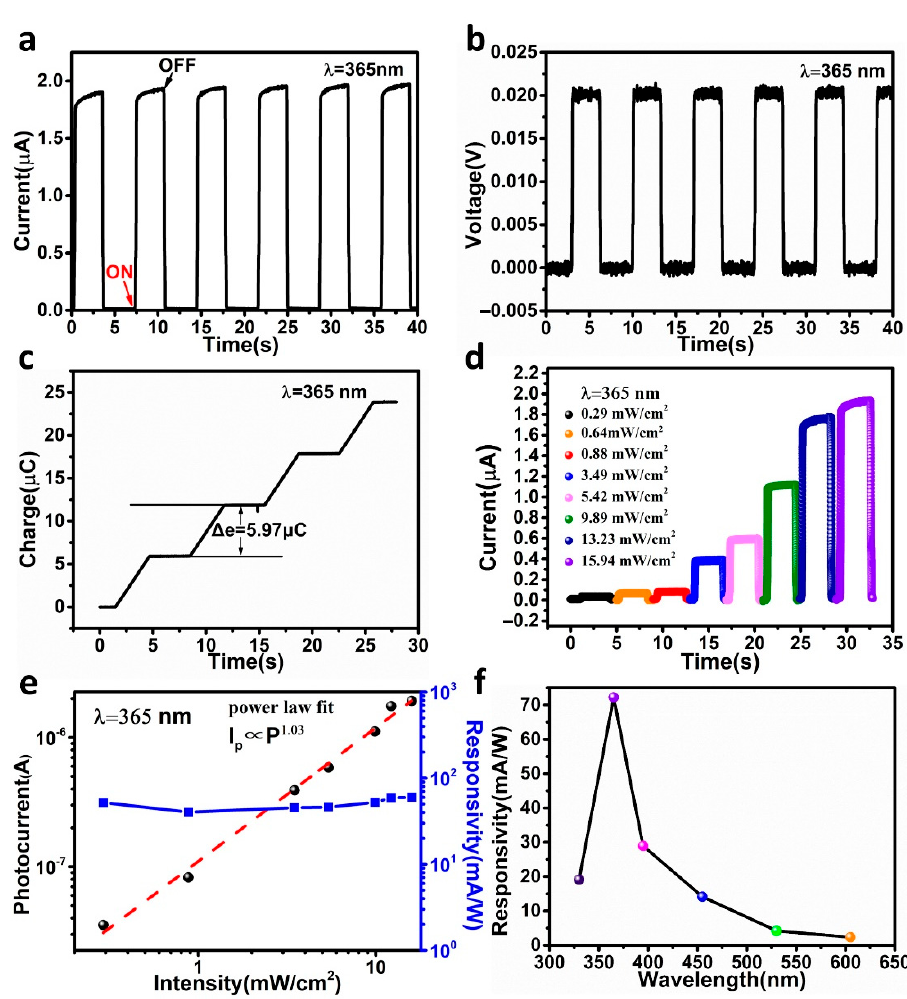
Figure 3. Photodetection performance of IEFB-SP device. Photocurrent ( a ) and photovoltage ( b ) under 365-nm UV light illumination (15.94 mW/cm 2 ) at 0 V. ( c ) The number of transferred charges in each illumination. ( d ) Intensity-dependent photocurrent of the IEFB-SP device. ( e ) Photocurrent and responsivity as a function of illumination intensity. ( f ) Photoresponsivity at various wavelengths (325, 365, 396, 457, 532, and 607 nm).